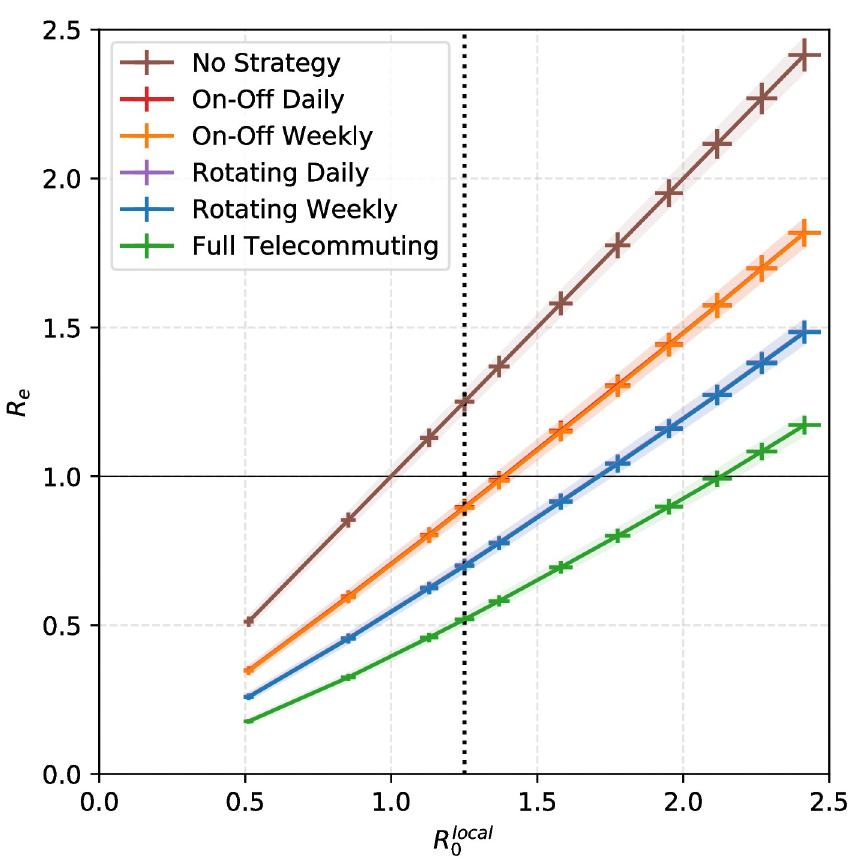
Fig 4. Impact of the strategies for the high school contact graph. The x -coordinate gives the value of the baseline reproduction number R local (mean number of persons infected by index case). For each strategy the y -coordinate gives 0 the mean value of the effective reproduction number as a result of using the strategy. Thus, for our baseline value ¼ 1 : 25 (dotted vertical line), doing nothing leads to R = 1.25 > 1, whereas, as long as R local < 1 : 38 , all strategies R local e 0 0 lead to R < 1. For each curve, the shaded areas correspond to 95% confidence intervals on the estimate of R local e 0 (calculated as a function of the model parameters: horizontal error bar) and on the estimate of R (as a function of the e strategy: vertical error